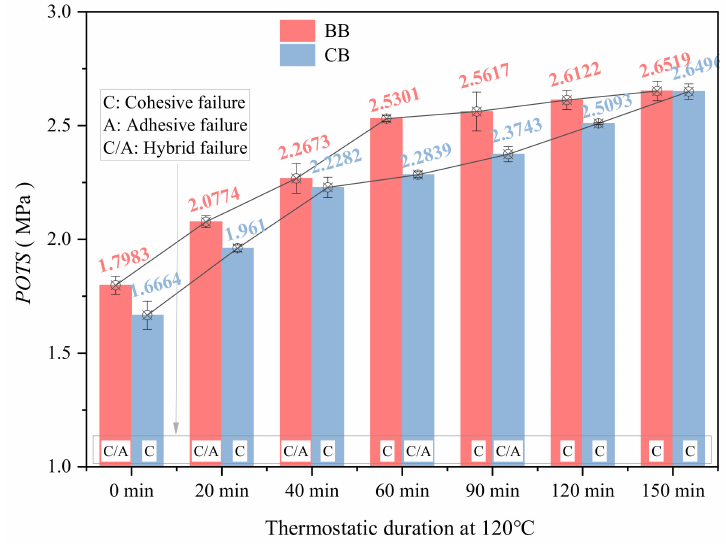
Figure 18. Bonding strength of BB and CB binder-aggregate